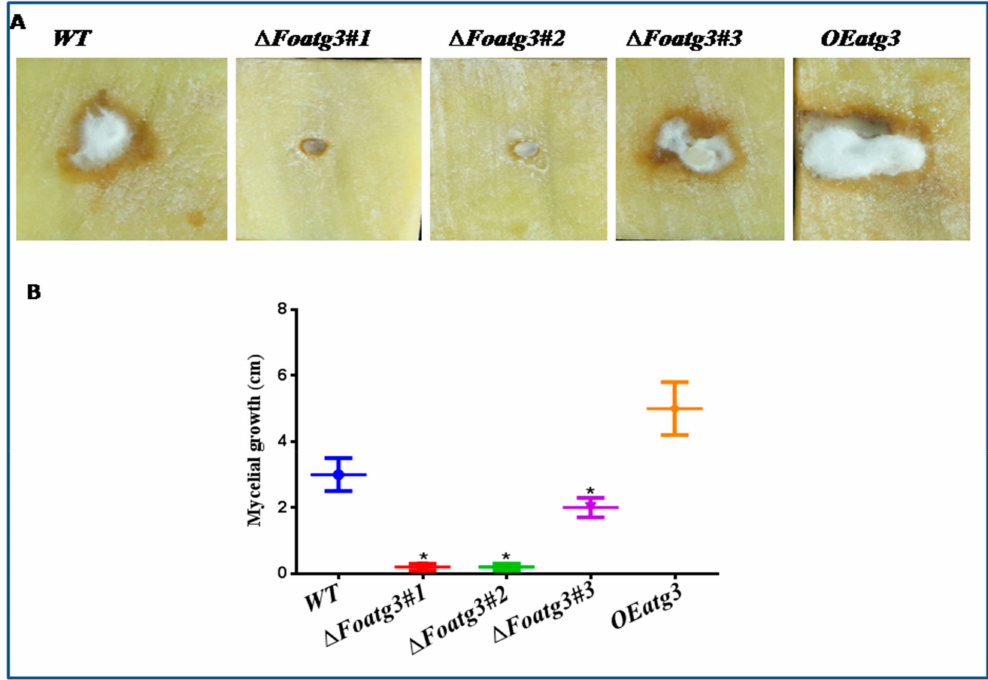
Figure 5. Foatg3 contributes to virulence on potato tuber slices. Mycelial growth was reduced in the Foatg3 ∆ mutant. ( A ) Tubers slices were inoculated with F. oxysporum strains kept at room temperature and photographed after 7 days. These images represent strains growth after 7 days. ( B ) Graph represents colony formation after six days. t -test with a * p value < 0.05 was performed for statistical